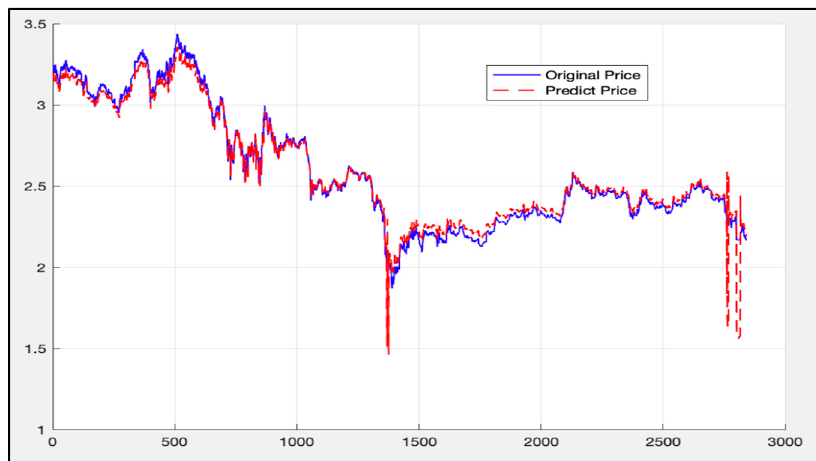
Figure 15. Comparison of LSTM prediction results with actual results (first 2850 data).